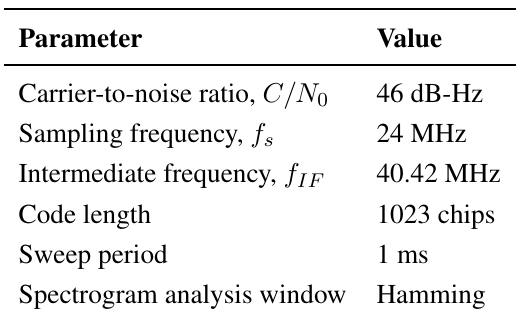
Table 1. Experimental setting parameters.